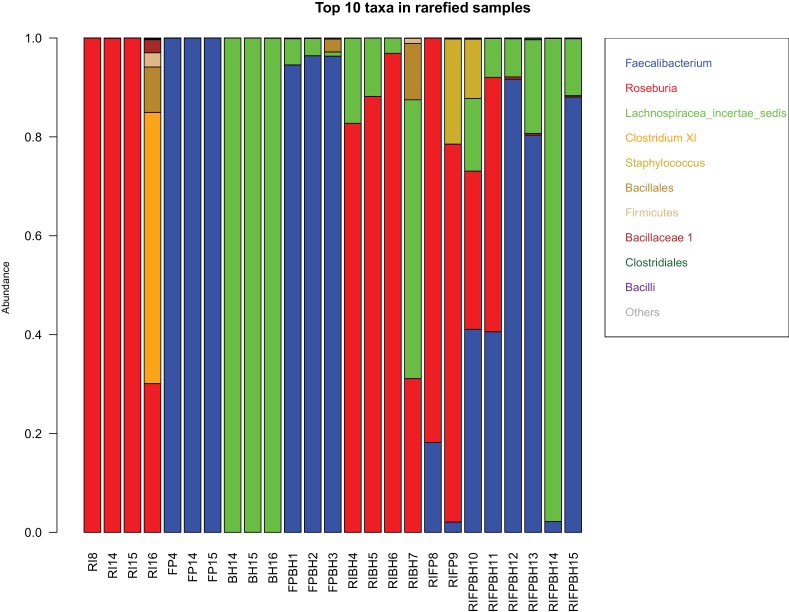
Test for prokaryotic contamination with 16S rRNA gene sequencing.For samples taken at the last time point, DNA was extracted and the V4 region of the 16S rRNA gene was amplified and sequenced. Raw reads are rarefied to 15,339 counts per sample and then converted into relative abundances. The top 10 taxa in each sample are shown. The abbreviations RI, FP and BH in sample identifiers stand for Roseburia intestinalis L1-82, Faecalibacterium prausnitzii A2-165 and Blautia hydrogenotrophica S5a33, respectively. The taxon Lachnospiraceae incertae sedis contains B. hydrogenotrophica S5a33. High relative abundances of potential contaminants (>10%) were found in one R. intestinalis L1-82 mono-culture (RI_16), one R. intestinalis L1-82/F. prausnitzii A2-165 co-culture (RI_FP_9) and one tri-culture (RI_FP_BH_10).